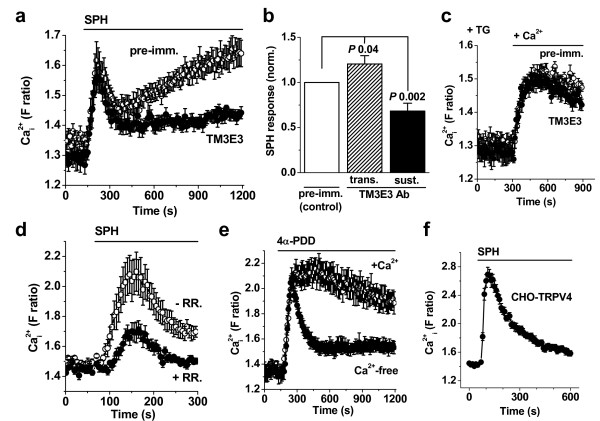
Inhibition of sustained sphingosine responses by anti-TRPM3 antibody in HIG-82 cells. Data were generated by intracellular Ca2+ measurement. (a) Cells were pre-treated with 1:4000 dilution of pre-immune serum (pre-imm.) or anti-TRPM3 antiserum before observing responses to 20 μM sphingosine (SPH). (b) Summary normalised data from 8 independent experiments showing inhibitory effect of TM3E3 on the sustained response to SPH. (c) Lack of effect of TM3E3 on Ca2+ entry in cells store-depleted by 1 μM thapsigargin (TG) for 30 min in Ca2+-free extracellular solution followed by re-addition of 1.5 mM Ca (+Ca2+); representative of N/n = 24/3. (d-f) Investigation of the transient response to SPH. (d) Effect of 10 μM ruthenium red (+RR.) on the SPH response in HIG-82 cells; representative of N/n = 12/3. (e) Responses to 10 μM 4α-phorbol 12,13-didecanoate (4α-PDD) in HIG-82 cells in the presence (+Ca2+) and absence of extracellular Ca2+; representative of N/n = 16/2. (f) Representative of 3 independent experiments, responses to sphingosine (SPH, 20 μM) in CHO cells stably expressing TRPV4.